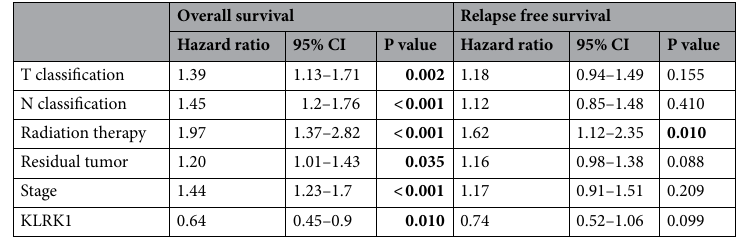
Table 6. Multivariate analysis of overall survival and relapse free survival in patients with lung adenocarcinoma cancer.